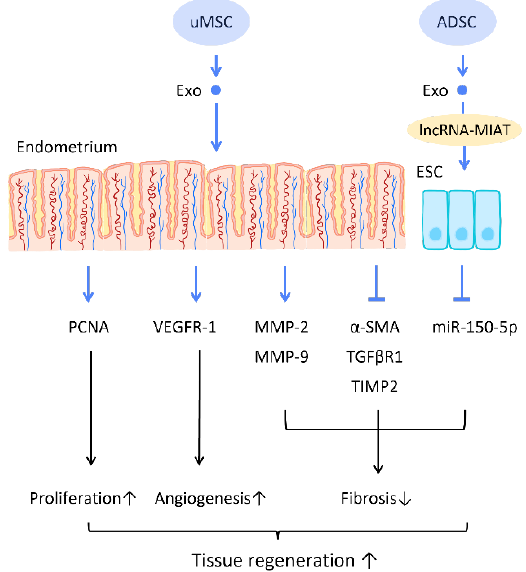
Figure 6. Molecular mechanisms of stem cell-derived exosomes regeneration of damaged endometrium. The administration of stem cell-derived exosomes is beneficial in female pregnancy, which alleviates endometrial fibrosis and enhances the regeneration competence in endometrial tissues. Abbreviation: Exo: exosome; MSC: mesenchymal stem cell; uMSC: uterus-derived SC;